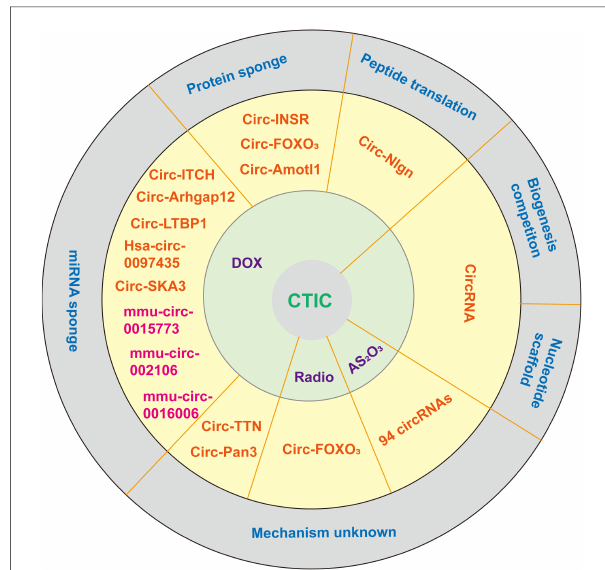
FIGURE 1 A schematic of different modes of action of circRNAs currently annotated in cells and in CTIC. In addition to pre-mRNA splicing, which can be affected by the interplay between back-splicing and canonical splicing for the same splice site selection, mature circRNAs themselves can act as decoys or sponges for miRNAs and proteins and as RNA scaffolds. A portion of the circRNA can translate peptides. The mechanism of another group of circRNAs is still unclear in CTIC. The pink labeled circular RNAs have potential interaction with miRNA, but further experimental veri fi cation is needed to con fi rm this. miRNA, microRNA; circRNA, circular